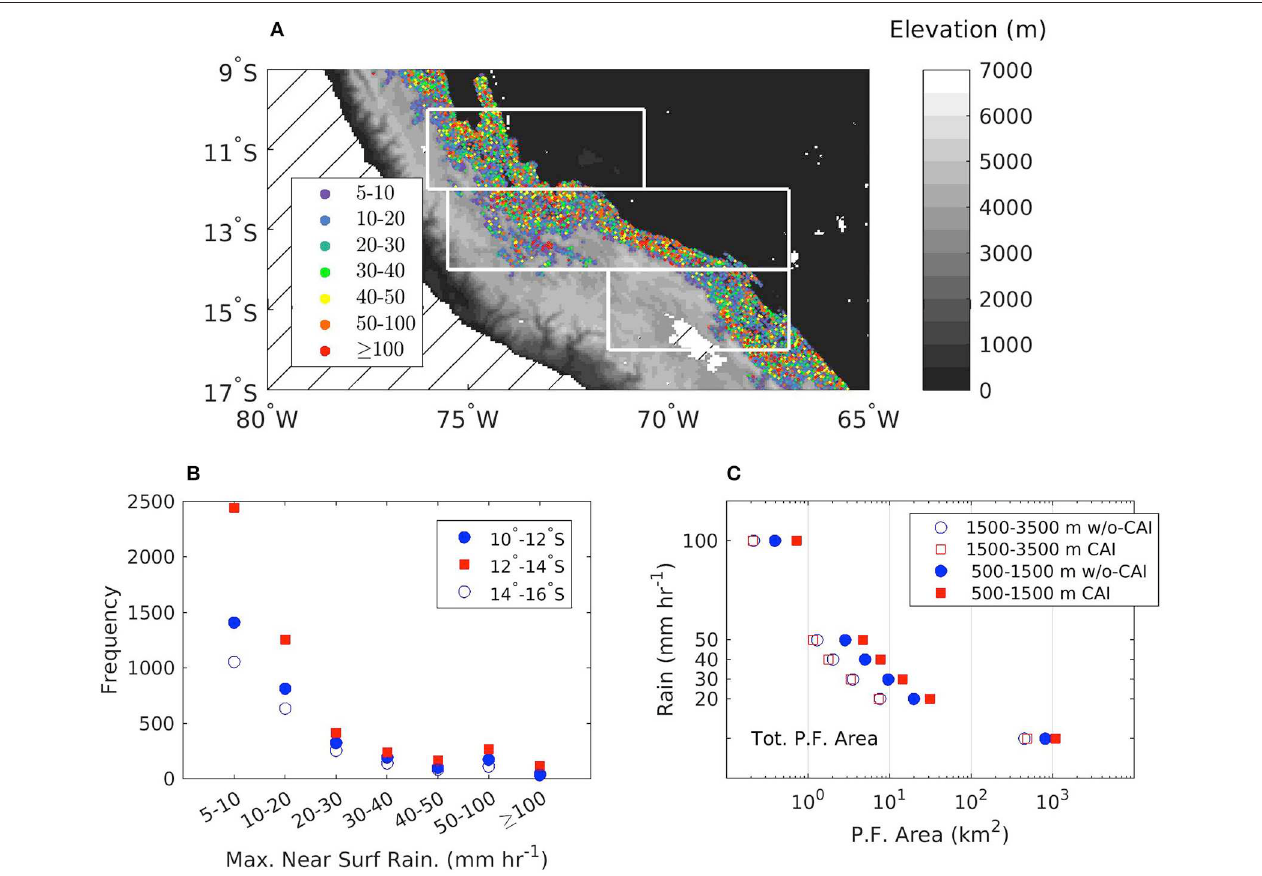
FIGURE 12 | (A) Map of maximum near surface rain rate for the 16-year composite of TRMM Precipitation Features discussed in section Data and methodology overlaying the topography of the Central Andes and adjacent regions. The white boxes delimit three latitude bands including the Andes hot-spot area (central box, also the Madre de Dios rain-gauge network Figure 1 ) used for analysis in Figure 13 . (B) The frequency of TRMM PFs binned with maximum near-surface rainfall rates for each latitude band. (C) Distribution of PF areal extent as a function of average rainfall rate for two elevation bands with and without CAI conditions.